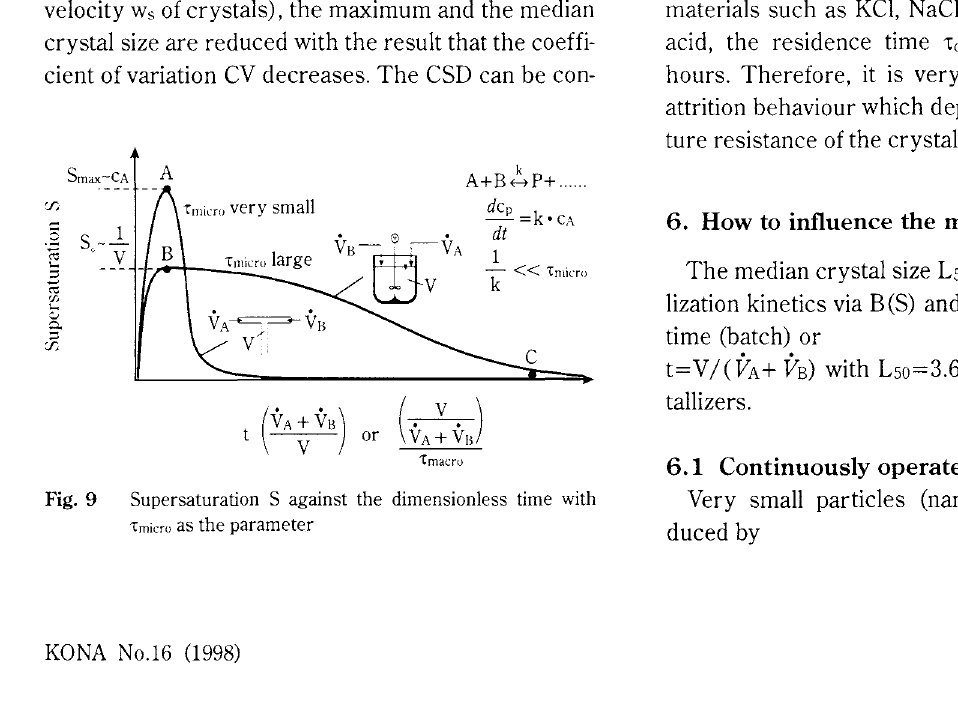
KONA No.l6 (1998)